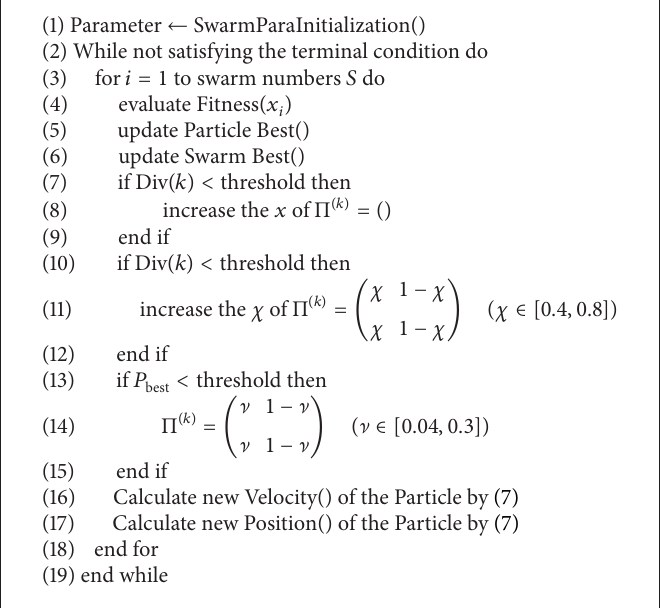
Algorithm 1: Pseudocode of the